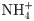
Simulated cation profile (as moving average over 2Å) in the K+ (KcsA) ion channel SF.[Na+·X] pink, [K+·X] black, [NH4+·X] red and [Rb+·X] or [Tl+·X] light blue. Concentration minimum region used to calculate selectivity [−6.5 : −2.5].